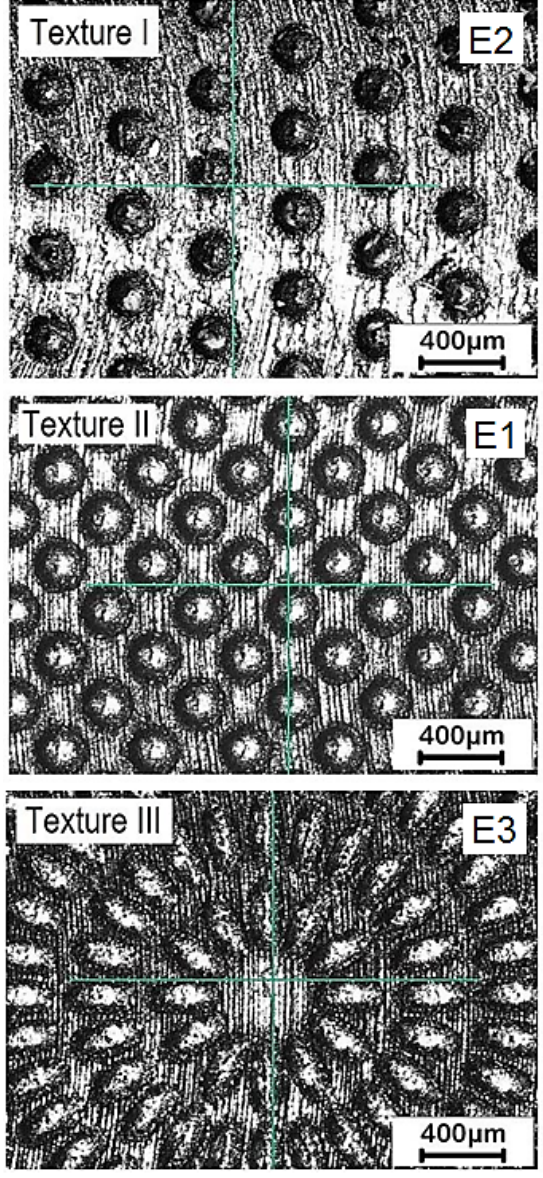
Figure 5: Chosen details of the surface textures produced on the planar area of sample I in preliminary